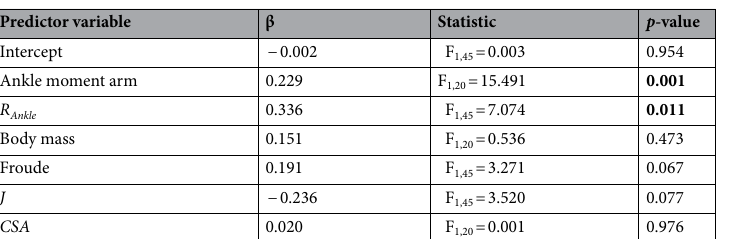
Table 3. Mixed-effect model of variation in ankle SNW with morphological and kinematic variables as fixed effects at sprint speed. Bolded p -values indicate significant fixed-effect predictors. β are the partial regression coefficients (i.e., β-weights). CSA is the cross-sectional area of the AT. R Ankle is the mean external moment arm of the ground reaction force. J is the GRF